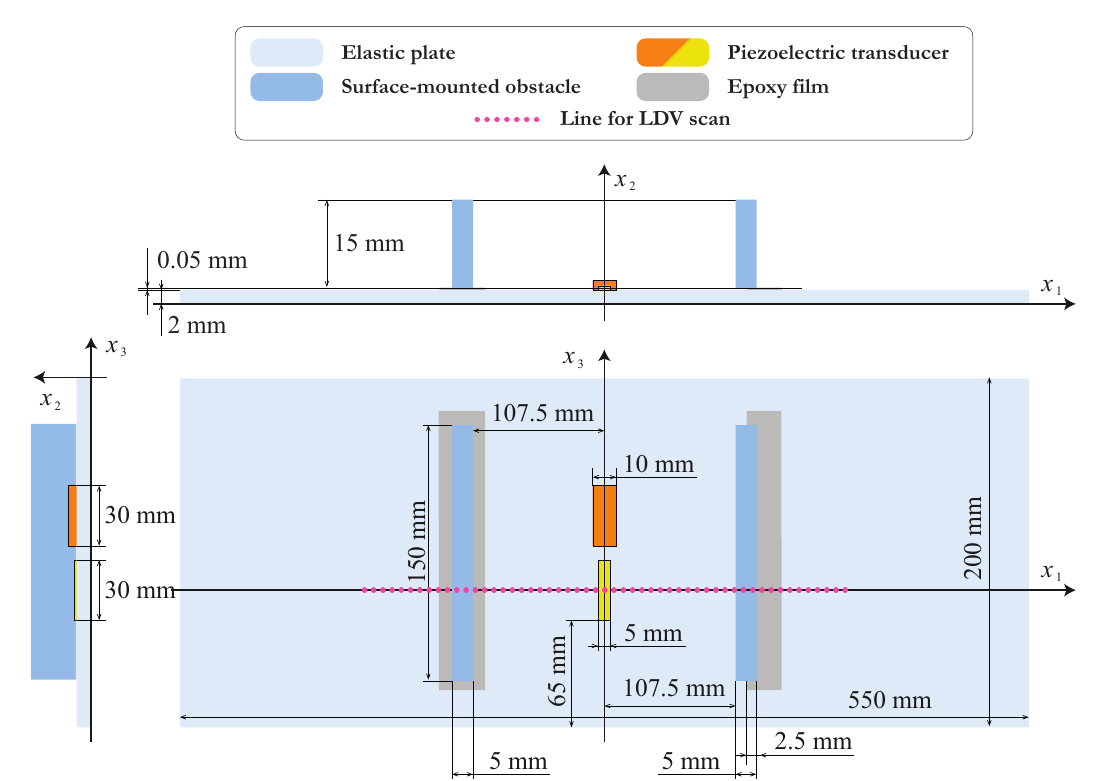
Figure 1. The sketch of the specimen used in the experiment.